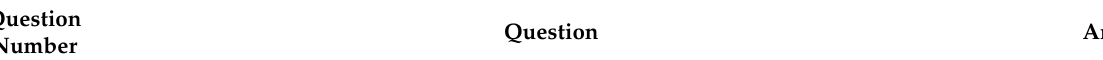
Table 3. Level 2 Eligibility Screening